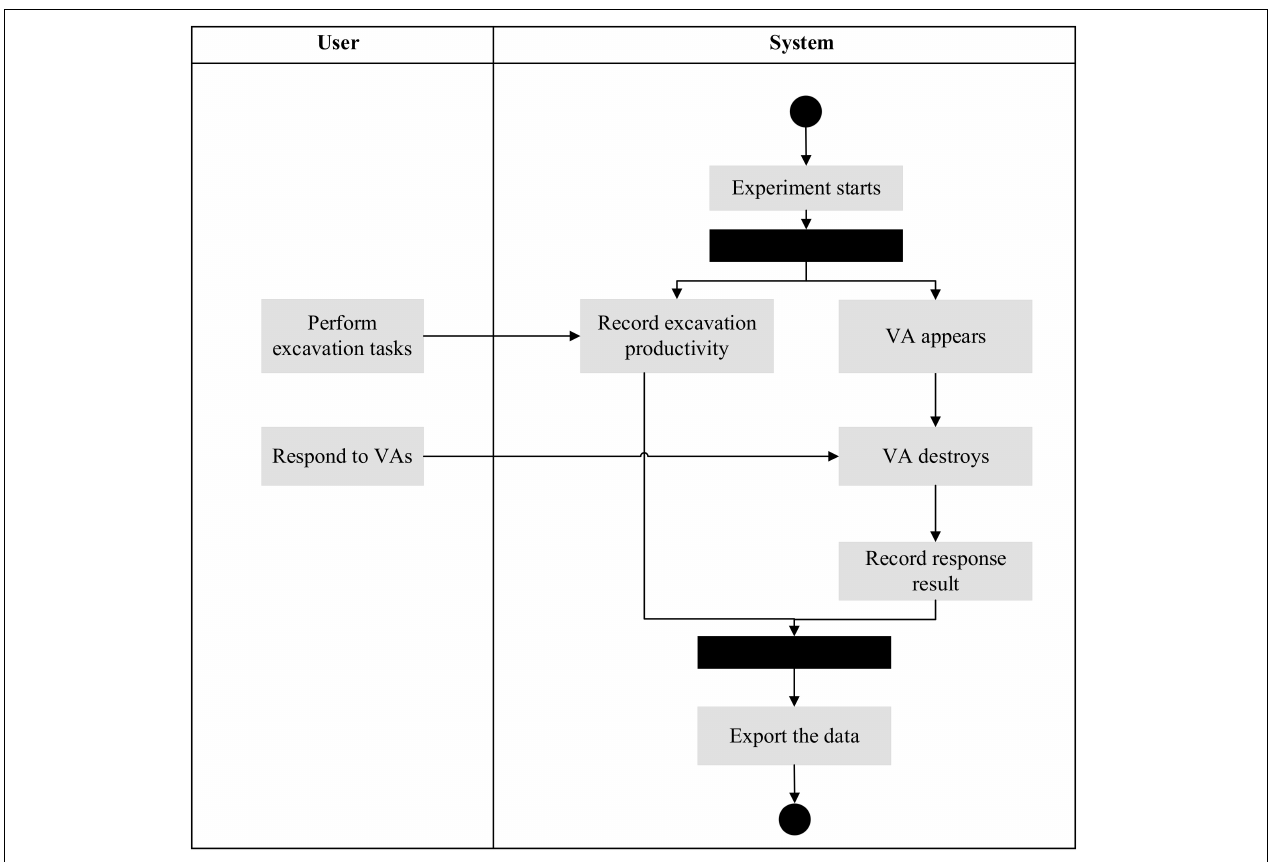
FIGURE 4 | Interaction mechanism of the